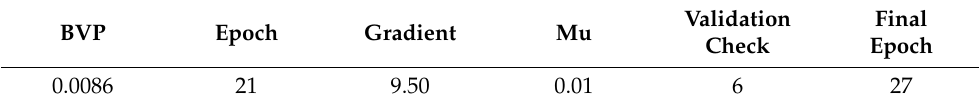
Table 4. Best validation performance and final state parameters.